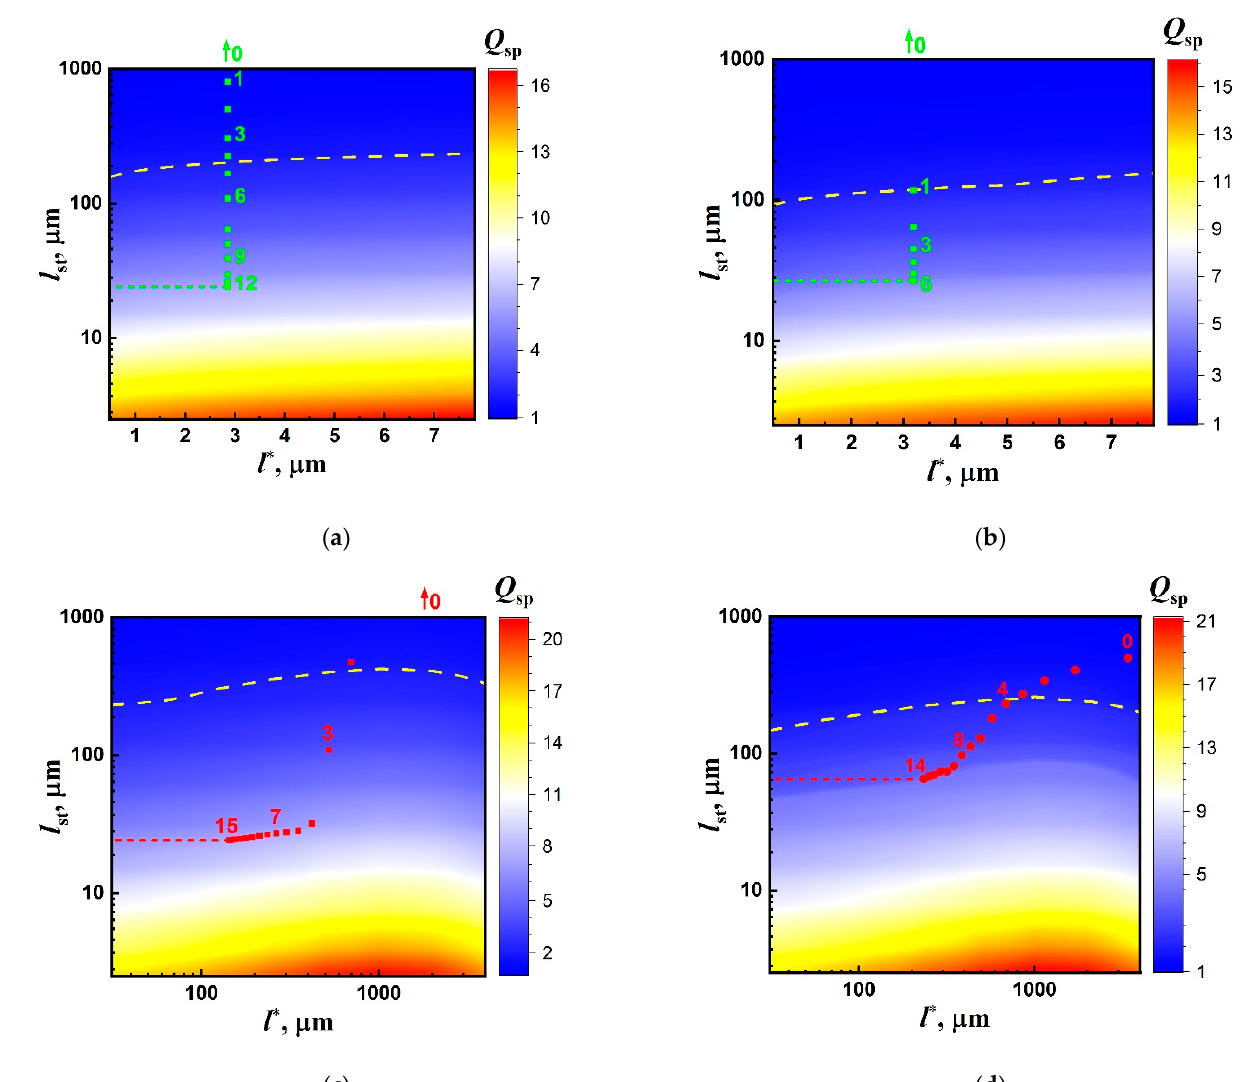
Figure 10. 2D color maps of the Q sp states of the examined systems in the ( l ∗ , l st ) domain (modeling results) with the experimental data (separate cyan and red markers; selective numbering of the markers corresponds to those used in Figures 3 and 5). ( a )—R6G-doped layer (#1); ( b )—DCM-doped layer (#1); ( c )—R6G-based suspension (#2); ( d )—DCM-based suspension (#2). Dashed cyan and red lines mark the expected values l st , ext corresponding to the crowded experimental